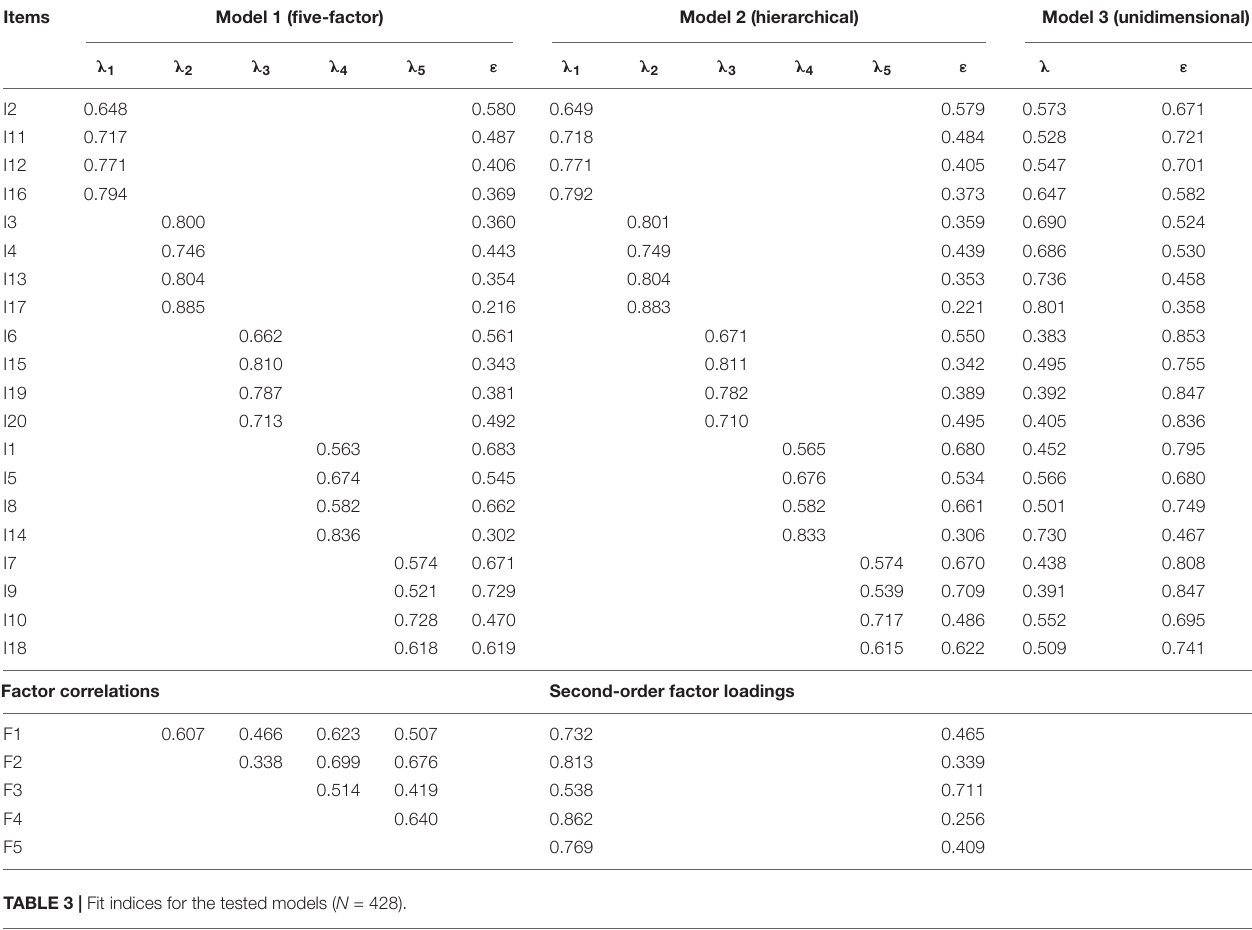
TABLE 2 | Factor loadings and correlations (completely standardized).